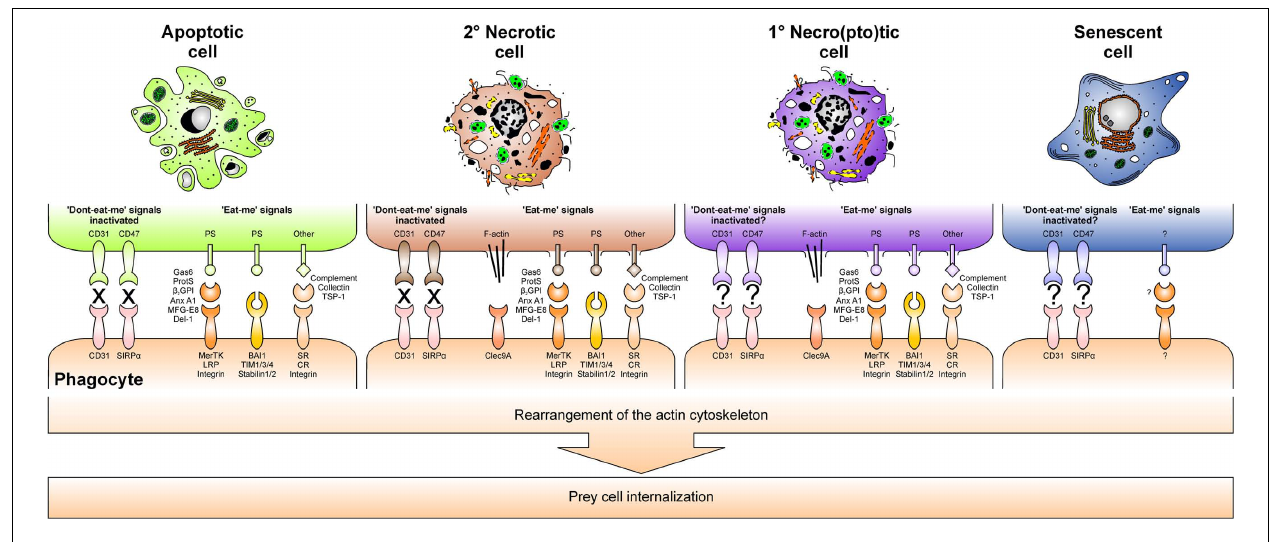
FIGURE 4 | “Eat-me” signals and inactivated “don’t-eat-me” signals together with their respective phagocyte receptors orchestrate dying cell